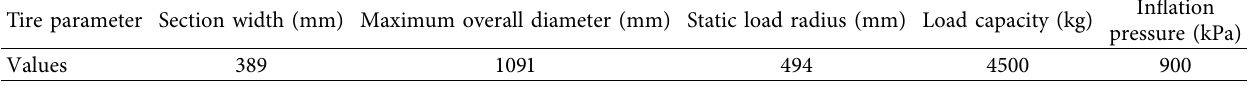
Table 1: Parameters of radial tire 385/65R22.5